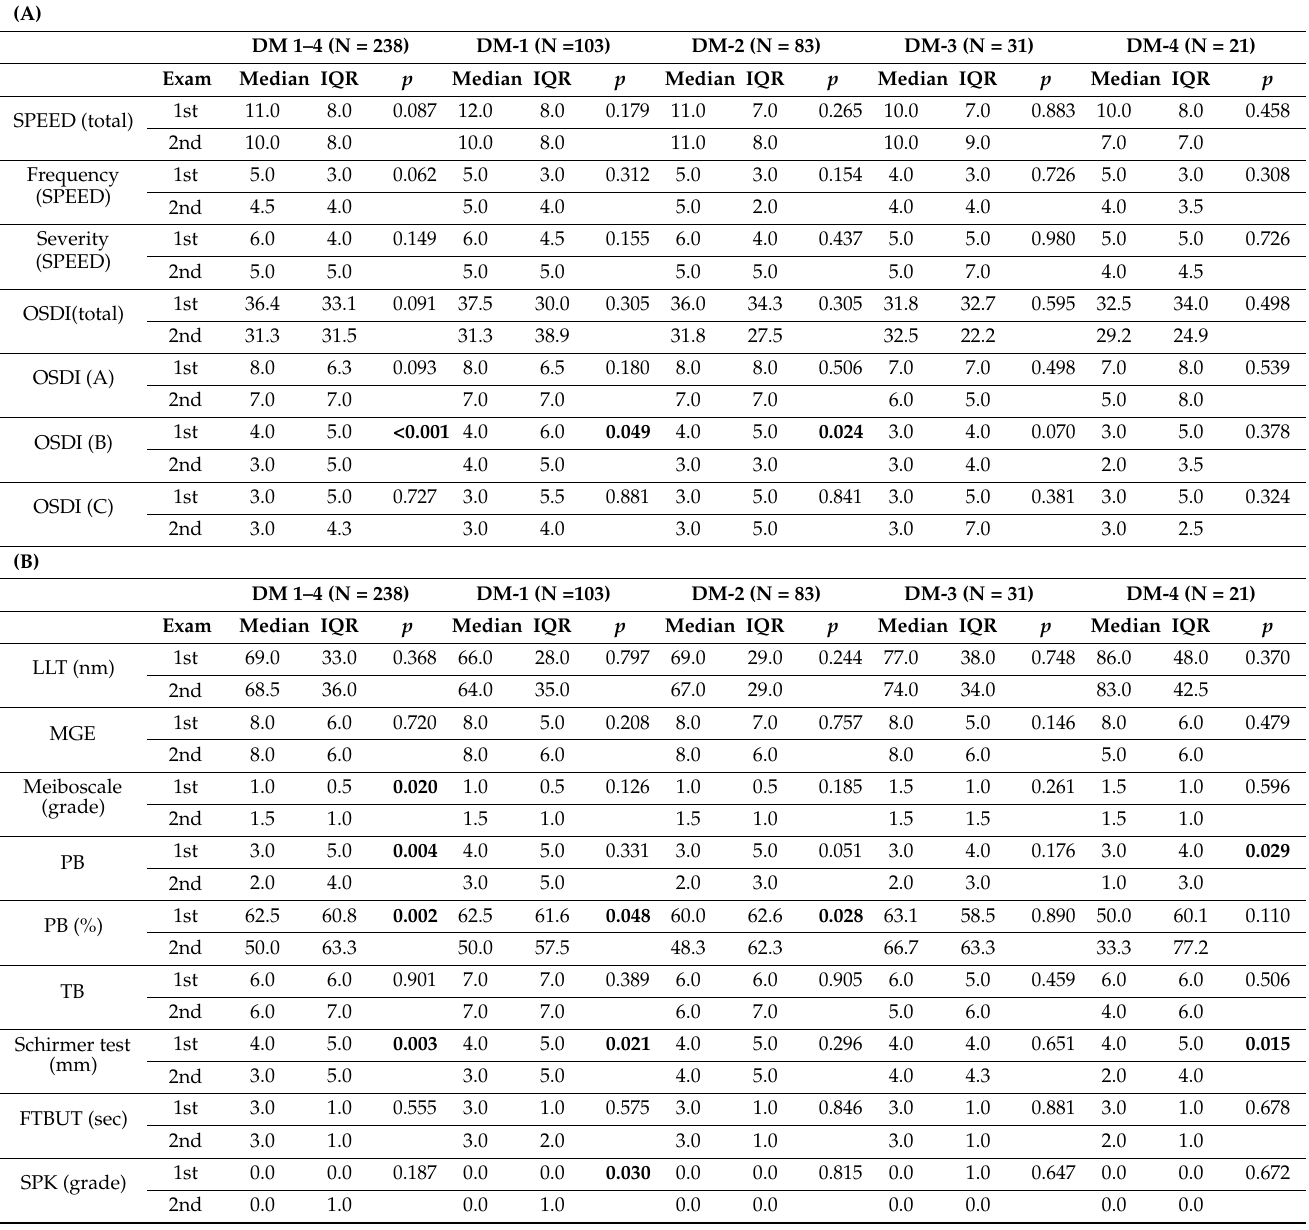
Table 8. Summary of subjective and objective dry-eye parameters in patients who did not perform lid hygiene. (A) Summary of subjective symptoms of 1st and 2nd examination. (B) Summary of objective signs of 1st and 2nd